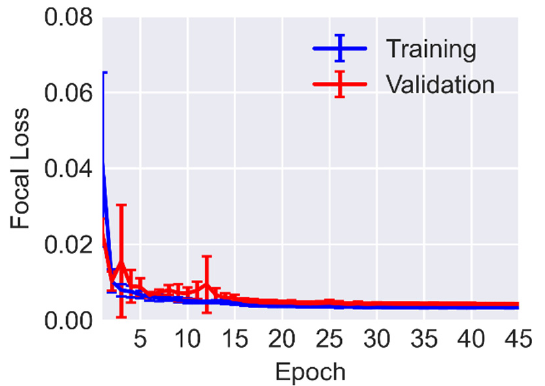
Figure 6. Focal Loss versus epochs for 5-fold cross-validation.